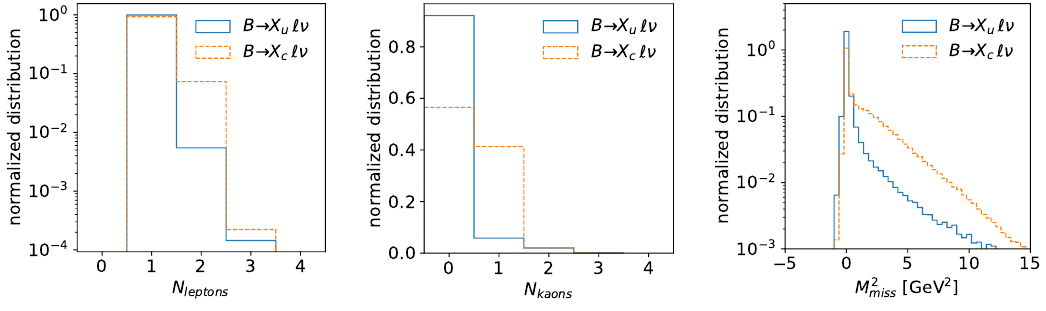
Figure 4 . High-level features of the E VT G EN sample. Number of leptons N ‘ (left), number of kaons N (middle) and missing mass squared M 2 kaons some of the